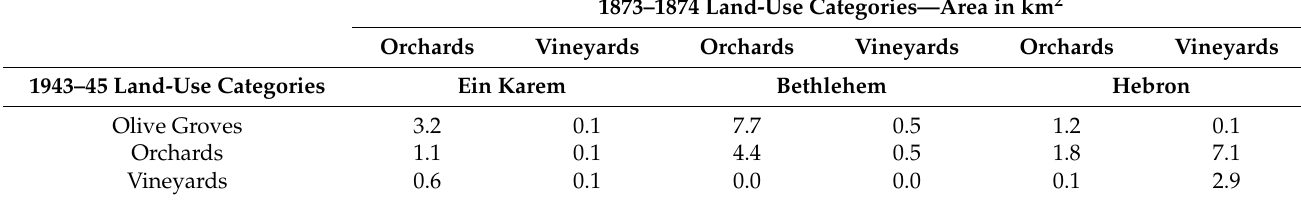
Table 3. The continuity of location conversion between the agricultural land-use categories in 1873–1874 with the land cover in 1943–1945. The table shows the amount of change in square kilometers.